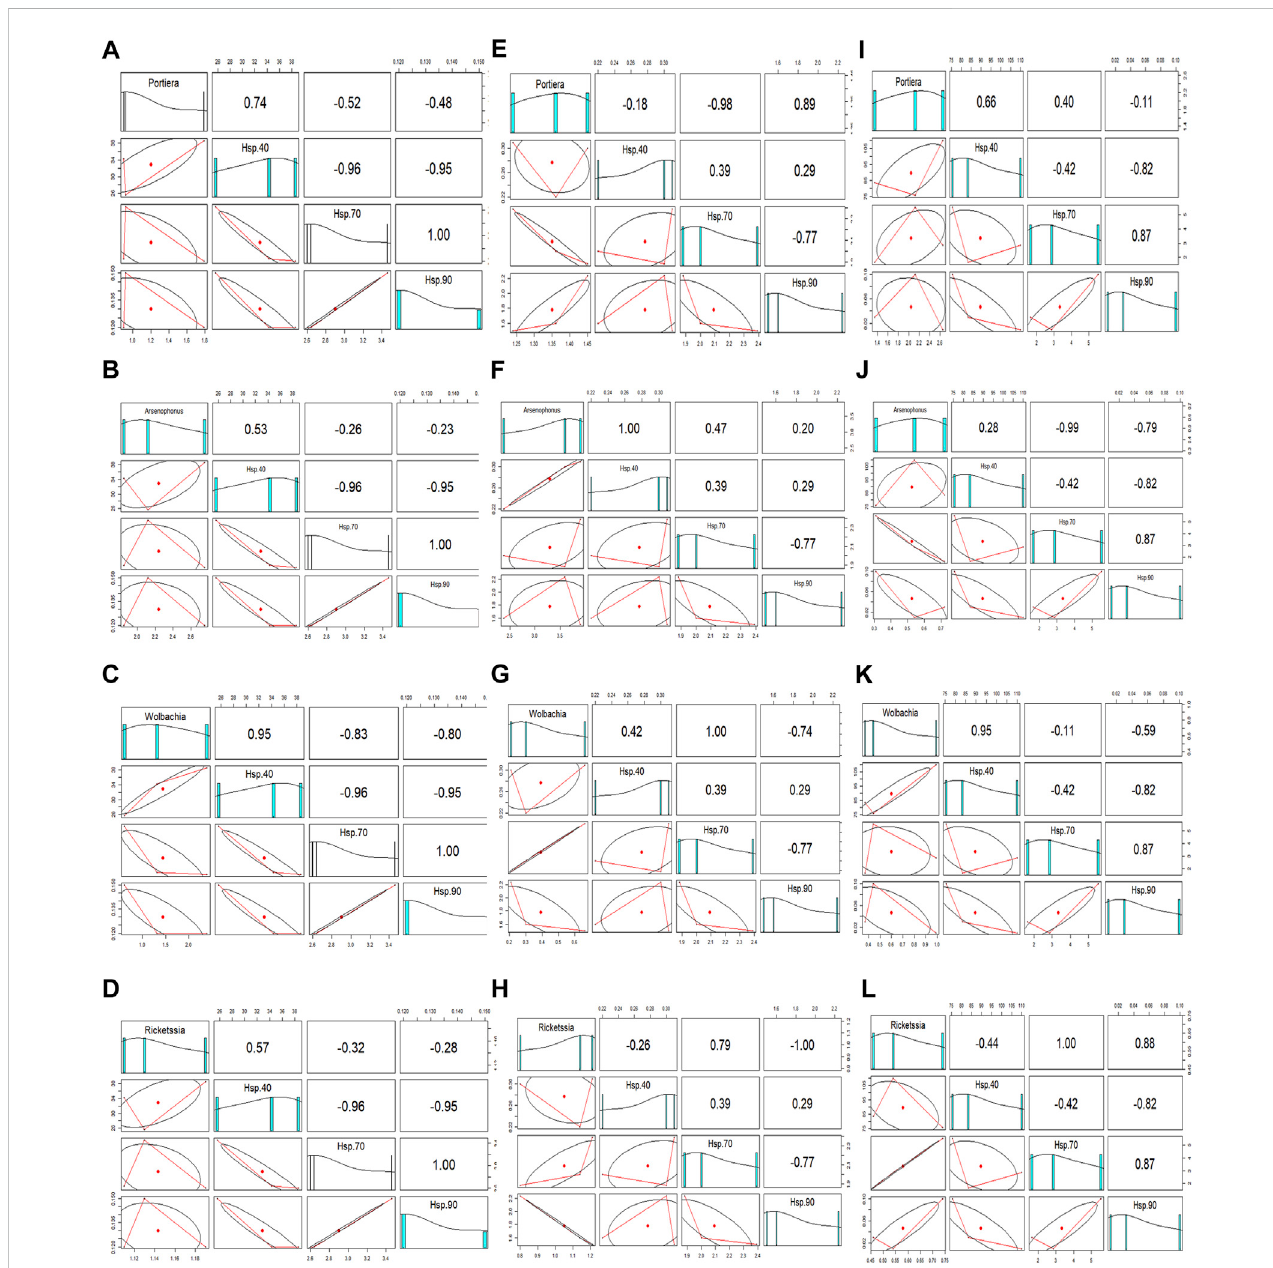
Correlation of relative endosymbiont ( Portiera, Arsenophonus, Wolbachia , and Rickettsia ) titres and Hsp gene (Hsp40, Hsp70, and Hsp90) expression, at (A – D) 12 ° C, (E – H) 18 ° C, and (I – L) 44 ° C.